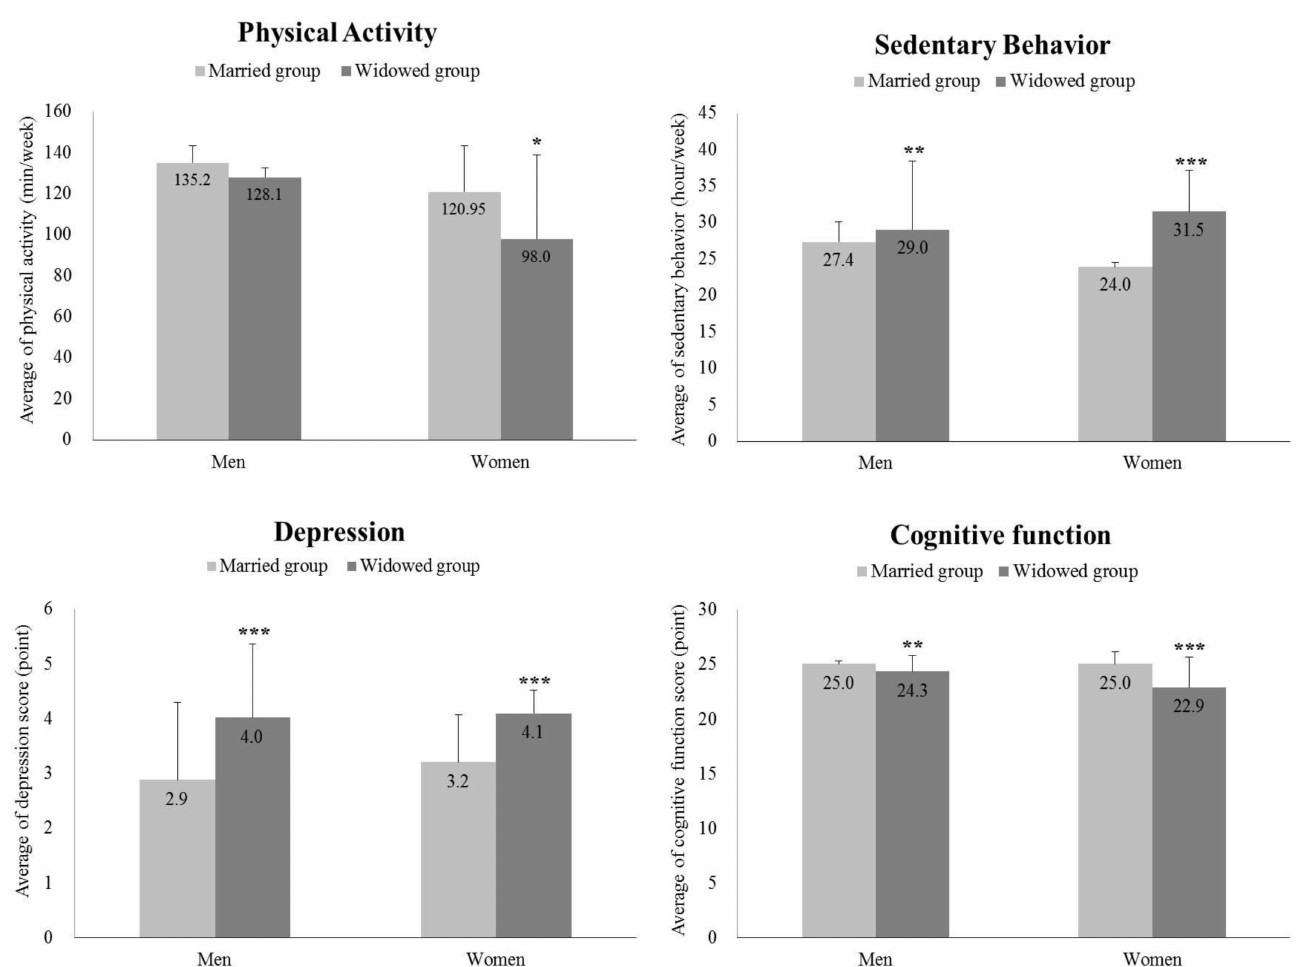
Figure 1. The comparisons of participation time in physical activity and sedentary behavior and score of depression and cognitive function in gender and groups. *** p < 0.001, ** p < 0.01, * p <